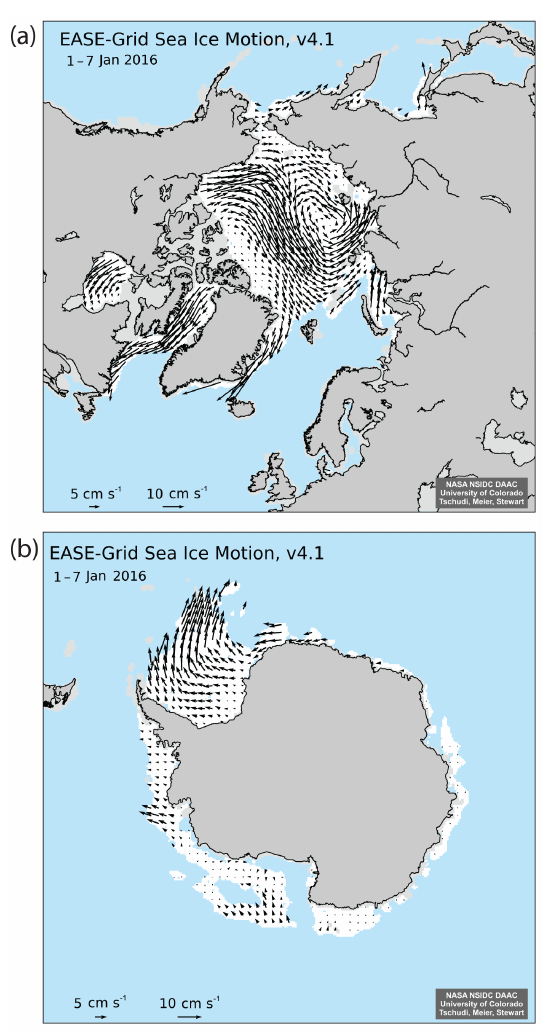
Figure 5. Example EASE-Grid sea ice motion for the Arctic region for the week of 1–7 January 2016 for (a) Arctic and (b) Antarc- tic. White indicates the sea ice mask region ( > 15% concentra- tion). Note that motions are not retrieved in the Canadian Arctic Archipelago region or near coasts in the Arctic. Every fourth vector is plotted for easier